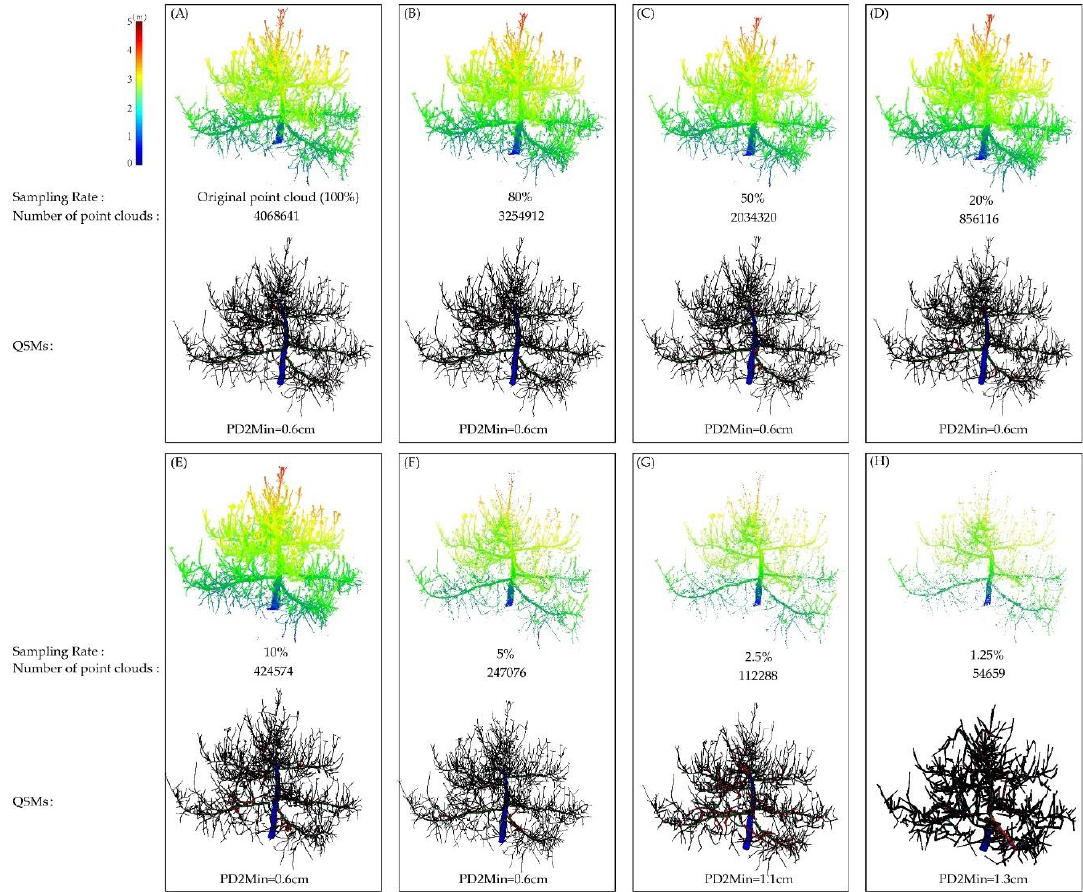
Figure 10. The effect of point cloud sampling rate on the QSMs based on TLS; except for PD2Min, all other parameters are set to fixed values. ( A ) Original point cloud (number of points is 4,068,641); ( B ) when the sampling rate is 80%, the number of points is 3,254,912, PD2Min = 0.6 cm; ( C ) when the sampling rate is 50%, the number of points is 2,034,320, PD2Min = 0.6 cm; ( D ) when the sampling rate is 20%, the number of points is 856,116, PD2Min = 0.6 cm; ( E ) when the sampling rate is 10%, the number of points is 424,574, PD2Min = 0.6 cm; ( F ) when the sampling rate is 5%, the number of points is 247,076, PD2Min = 0.6 cm; ( G ) when the sampling rate is 2.5%, the number of points is 112,288, PD2Min = 1.1 cm; ( H ) when the sampling rate is 1.25%, the number of points is 54,659, PD2Min = 1.3 cm.